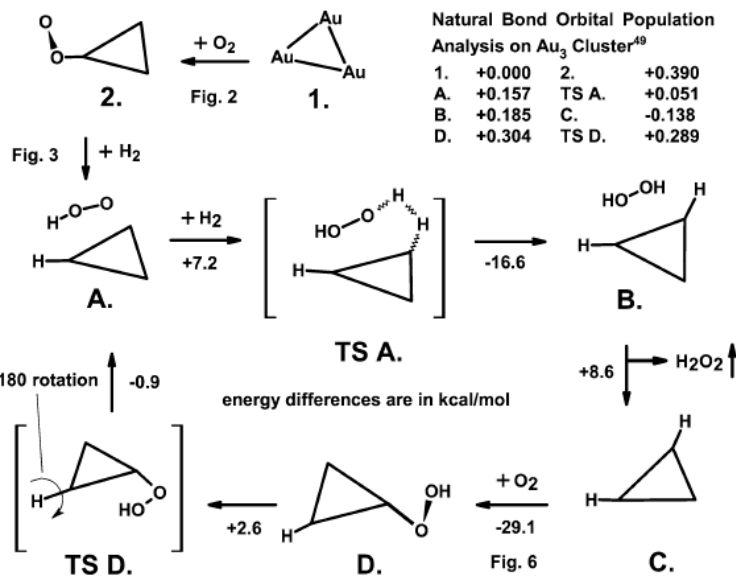
Figure 1. Catalytic cycle for the formation of H 2 O 2 over Au 3 (Au 3 cluster is represented by the triangle in each intermediate geometry) with two transition state geometries ( TS A and TS D ), identified with square brackets, and intermediates ( A – D ). Energy differences are shown in kcal/mol under each reaction arrow [83]. Copyright © 2004 Elsevier Inc.